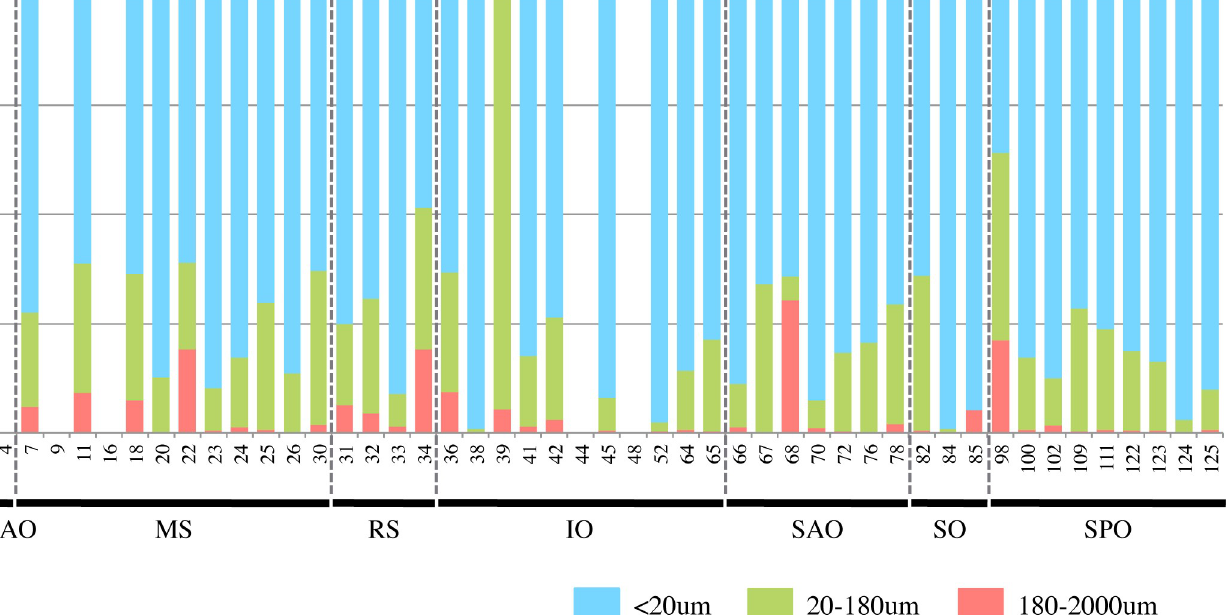
PLOS ONE | https://doi.org/10.1371/journal.pone.0208941 January 9,